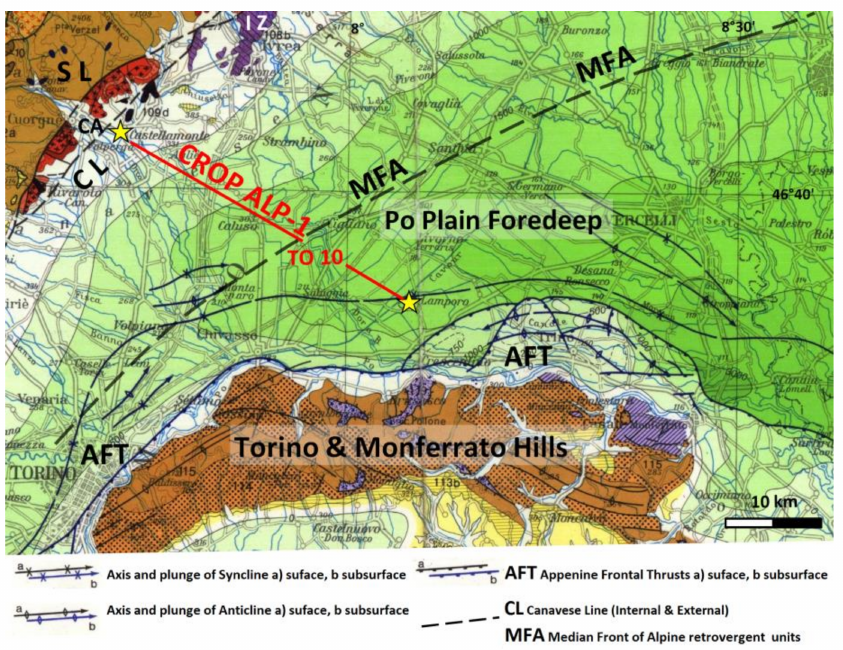
Figure 2. A subset of the Structural Model of Italy by CNR [21]. The CROP ALP-1 seismic profile is shown in red. AFT, Apennine Frontal Thrusts; MFA, Median Front of Alpine retrovergent units; CL, Canavese Line; CA, Canavese Zone; SL, Sesia-Lanzo Zone; IZ, Ivrea Zone. Within the Po plain the tectonics of the area, north of AFT, is characterized by the major “Saluggia” syncline and by a system of syncline-anticline